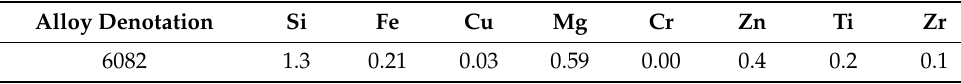
Table 1. Chemical composition of 6082 alloy in mass percentage.